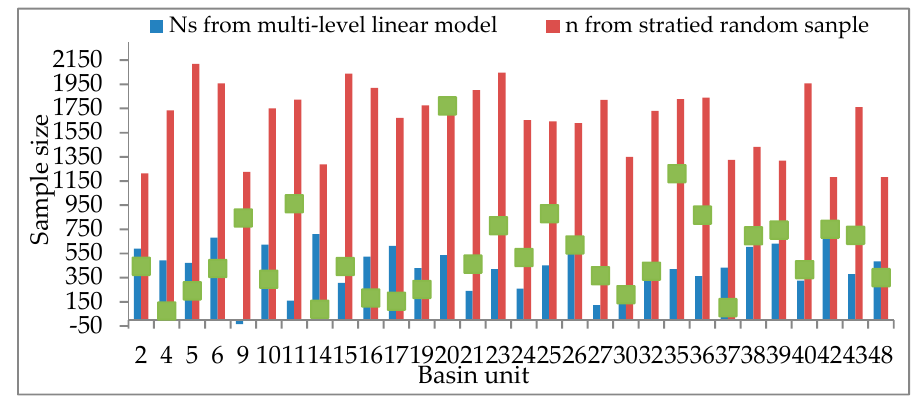
Figure 11. Histogram of sample sizes n and N S .